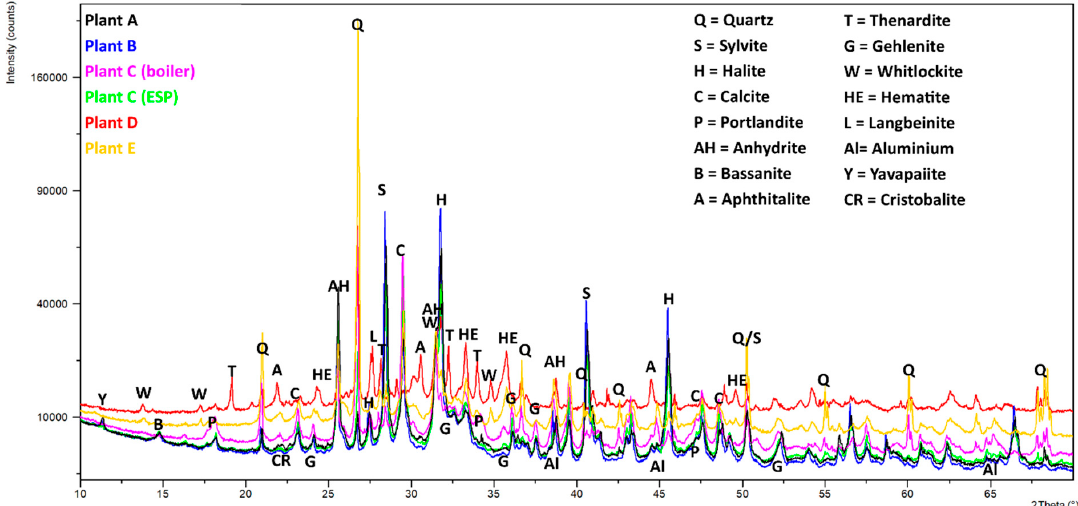
Figure 5. Powder XRD graphs (Cu K α ) of the six samples. The peaks of the main constituents (see